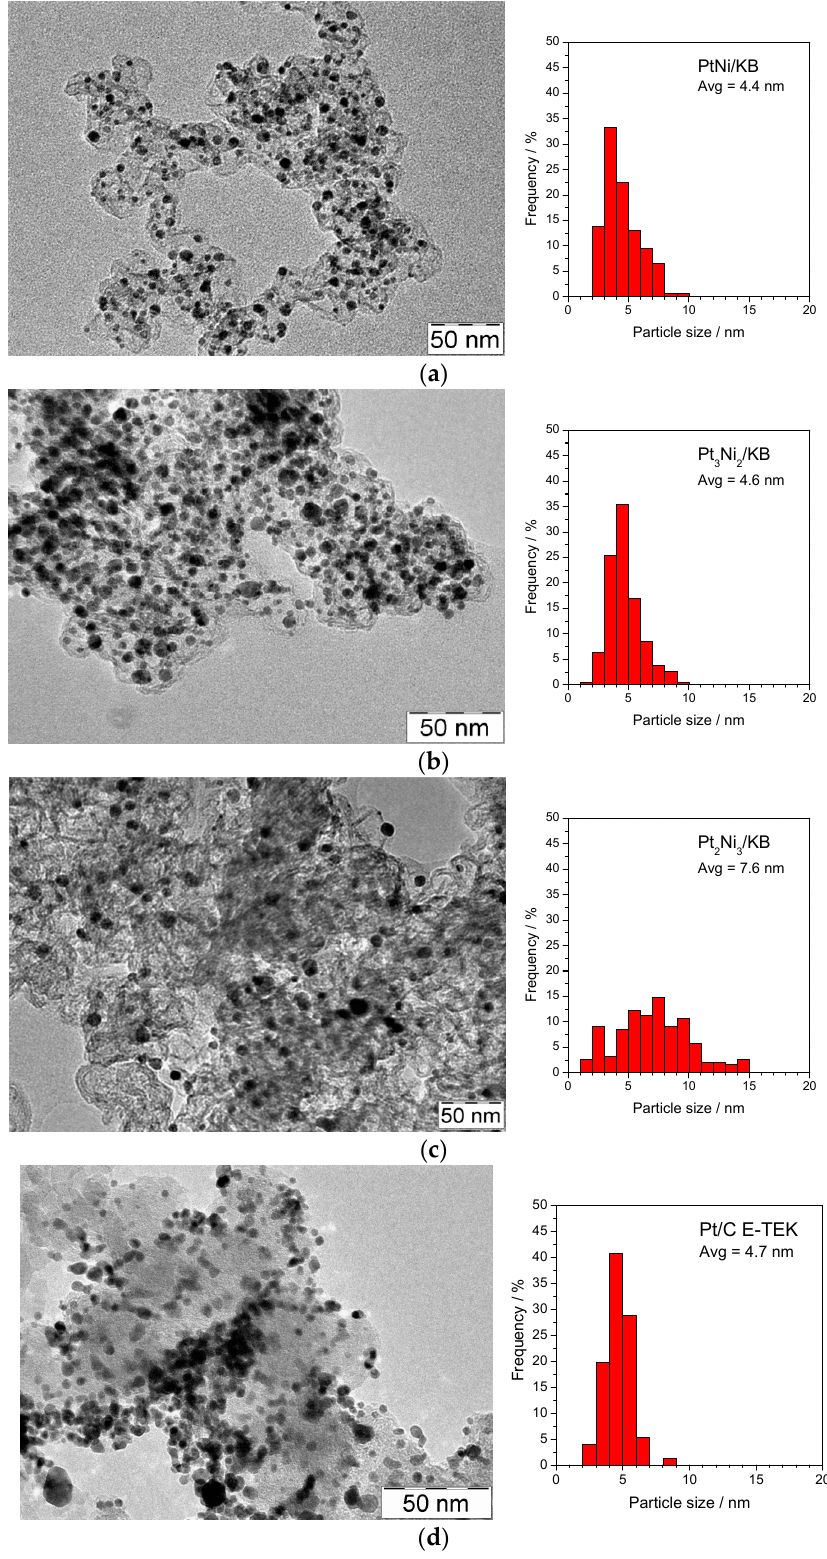
Figure 2. Transmission electron micrographs (TEM) analysis of carbon supported ( a ) Pt 1 Ni 1 ; ( b ) Pt 3 Ni 2 ; ( c ) Pt 2 Ni 3 catalysts after the thermal and leaching treatments and ( d ) Pt/C E-TEK catalyst.